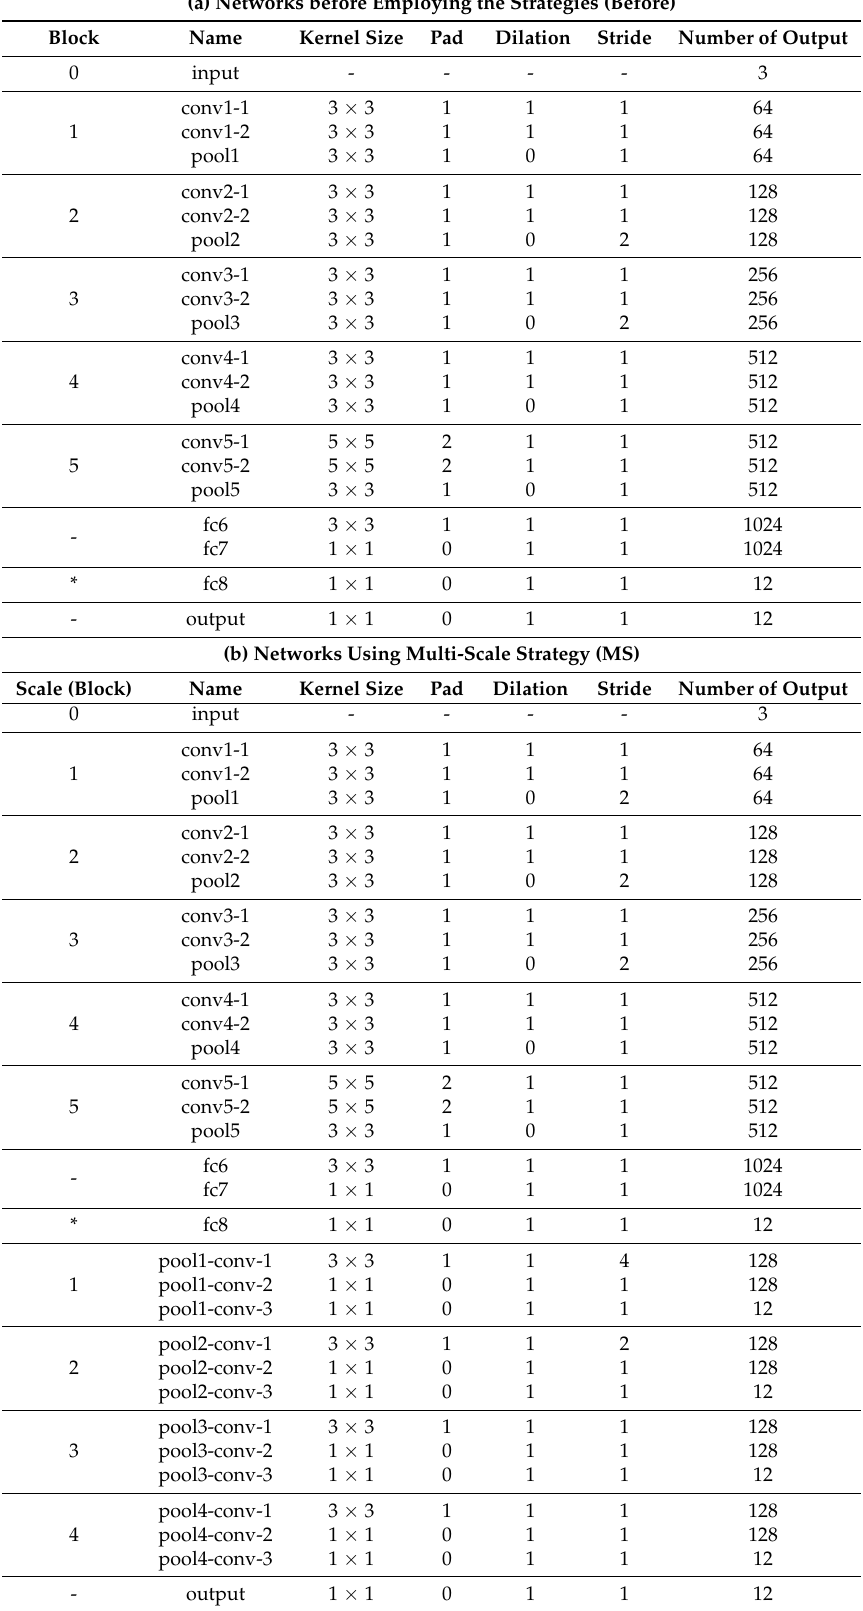
Table A1. Implementation details of the networks with different